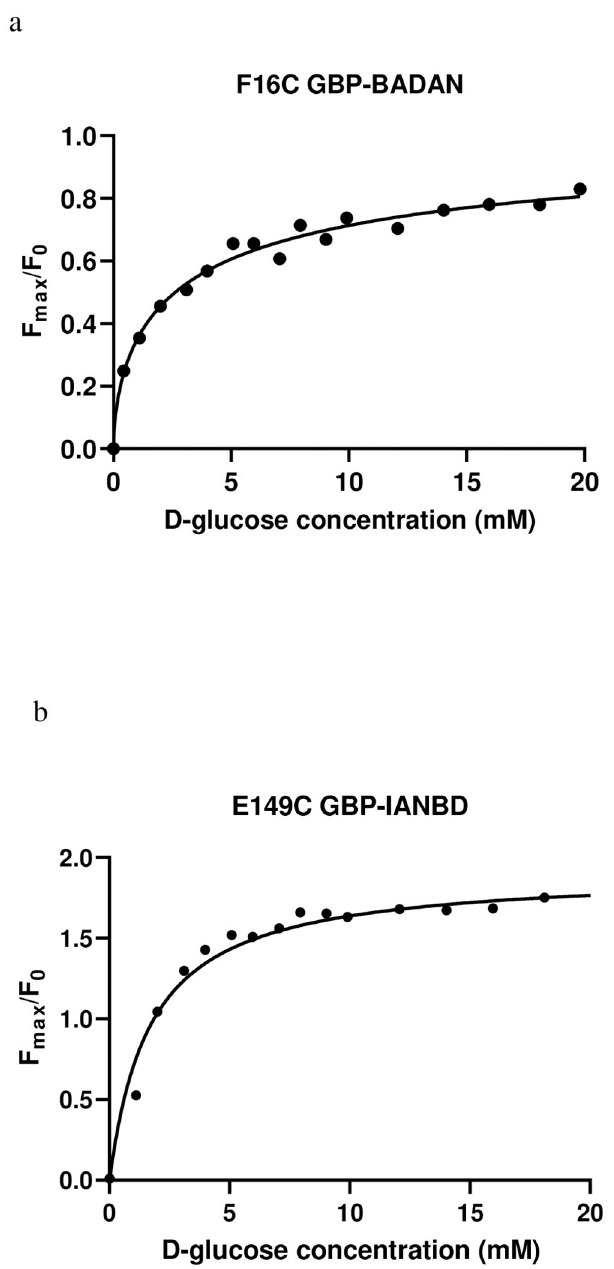
Fig 1. Fmax/F0 D-glucose concentration response curves for two single point GBP mutations. a. F16C labelled with BADAN and b. E149C labelled with IANBD. Curves were fitted using the one site-specific binding with Hill slope formulae in GraphPad